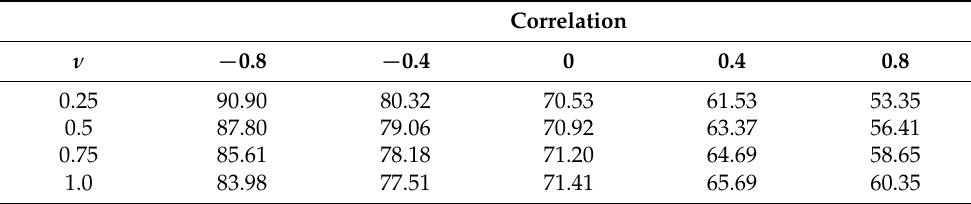
Table 4. Product of a put and a call.